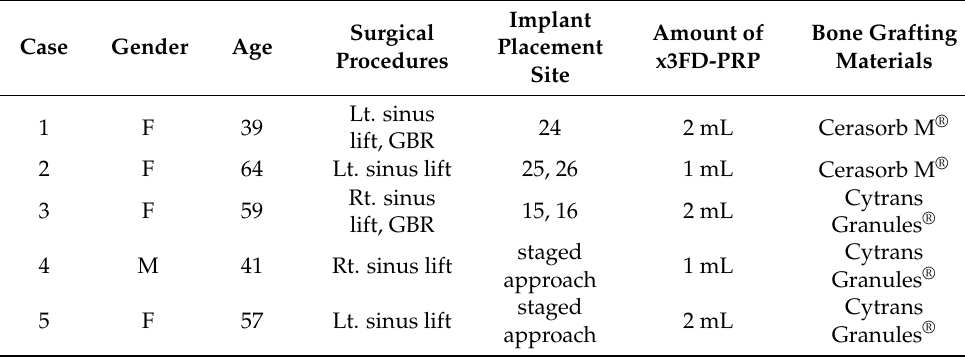
Table 1. List of the patients who participated in the clinical